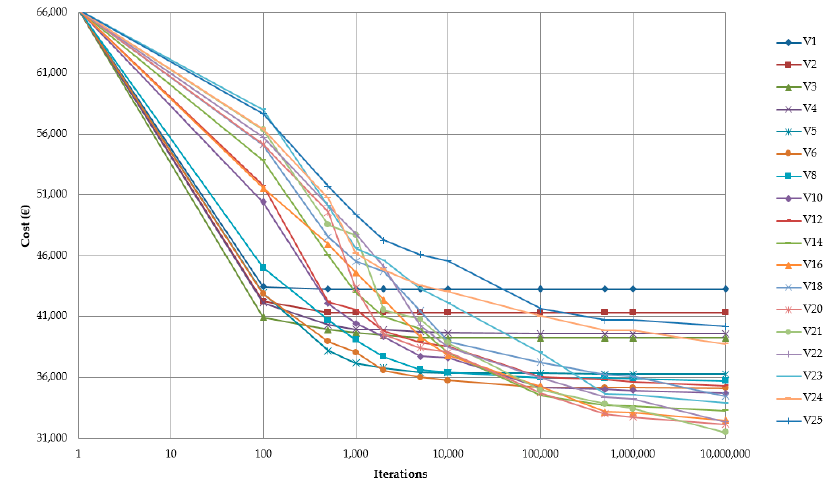
Figure 3. Average costs and number of iterations stop criterion 197